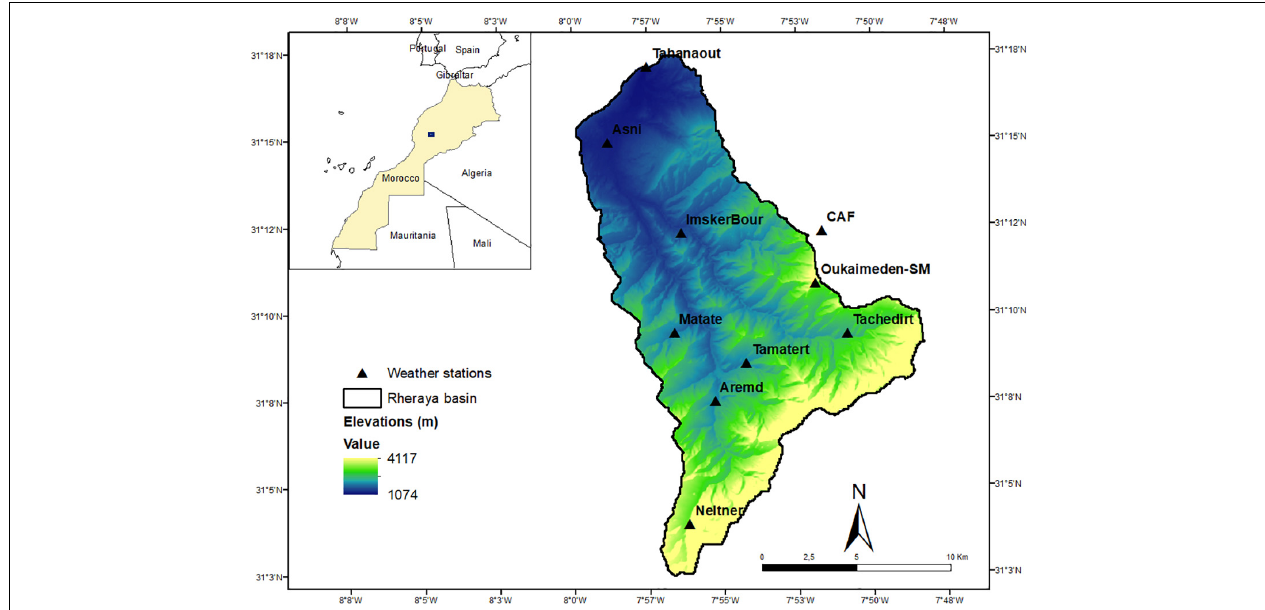
FIGURE 1 | Geographical location of the Rheraya basin and weather stations.